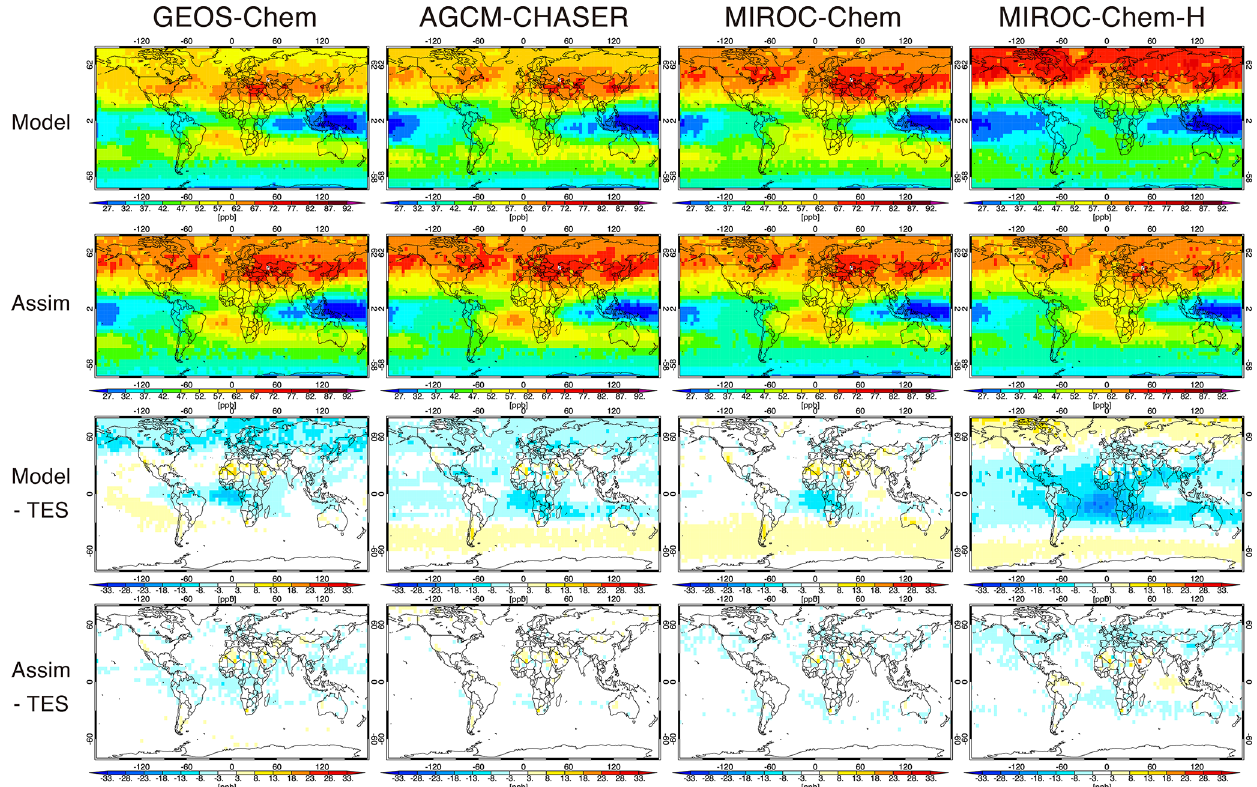
Figure 5. Comparisons of the spatial distributions of annual mean ozone concentrations between the TES measurements, control runs, and data assimilation analyses at 510hPa in 2007. Unit is parts per billion by